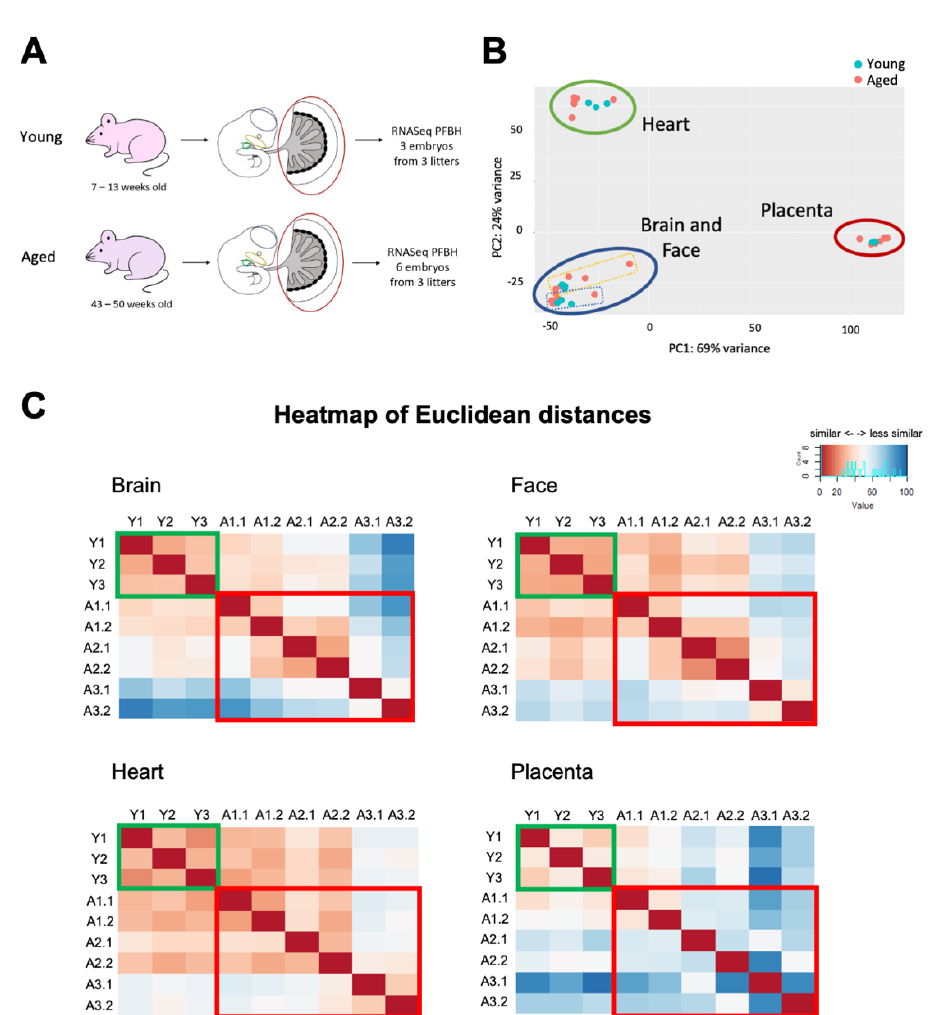
Figure 1. RNA-sequencing analysis of embryonic tissues and placentas from conceptuses developed in young and aged females. ( A ) Experimental design of tissue collection of placenta (P), face (F), brain (B), and heart (H) samples of E10.5 embryos. E10.5 embryos were obtained from young (7–13 weeks) or aged (43–50 weeks) C57BL/6N females. Tissues dissected are encircled and colour-coded: blue for brain, yellow for face, green for heart, and red for placenta. In the young cohort, tissues from 3 embryos were sequenced with one embryo per litter (Y1, Y2, Y3). In the aged cohort, tissues from 6 embryos were sequenced with two embryos per litter to account for increased variability. ( B ) PCA plot of RNA-seq data which clusters samples by tissue type. Circles demarcate samples belonging to the tissues indicated. Dotted yellow and blue rectangles demarcate face and brain samples, respectively. Blue and red dots correspond to tissue samples from young and aged females, respectively. ( C ) Data as in (B) plotted as heatmaps of Euclidean distances per tissue. Dark red indicates higher similarity, while dark blue indicates larger differences. Green and red boxes demarcate samples from young and aged females, respectively. The first and second numbers of sample IDs indicate the litter and embryo numbers, respectively. Table 1. Details of litters and embryos used.